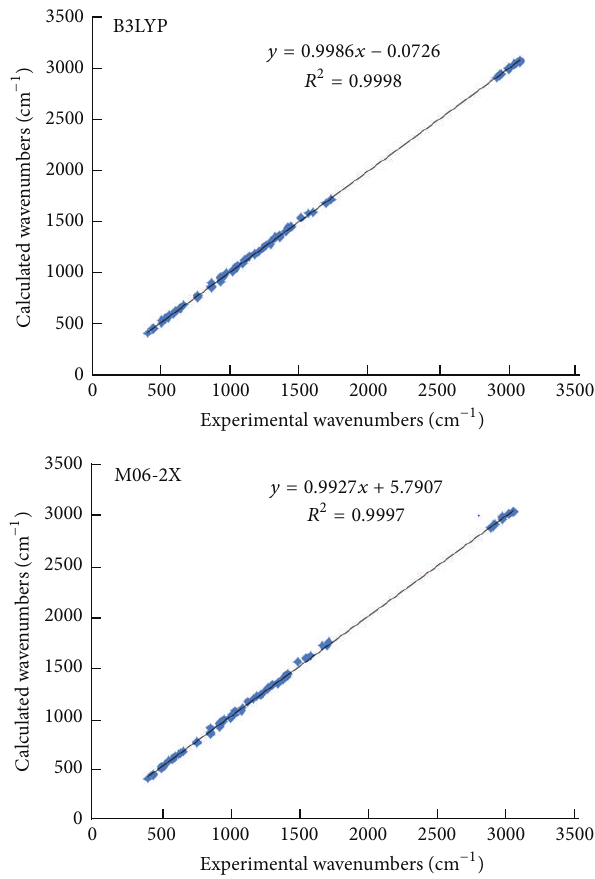
Figure 4: Correlation graphics of experimental and theoretical (scaled) wavenumbers of 2